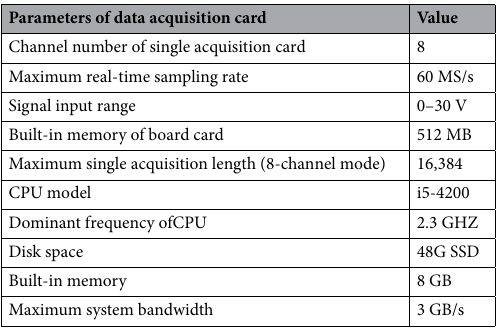
Table 2. The main parameters in the experimental platform.